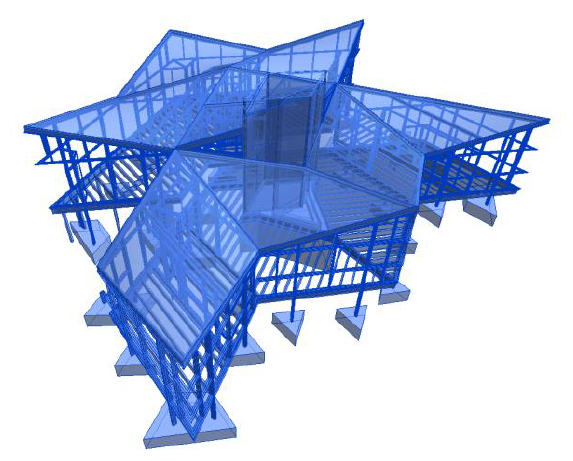
Figure 11. Image of Structural building elements from Pierre Jouan’s Thesis Building Information Model (BIM)